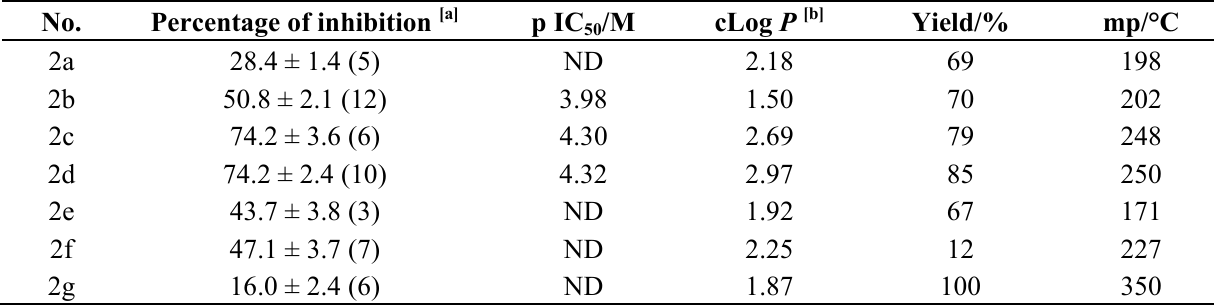
Table 1. Percent inhibition in the presence of 100 μ M compounds on GABA-induced inward currents, p IC , cLog P , and physical 50